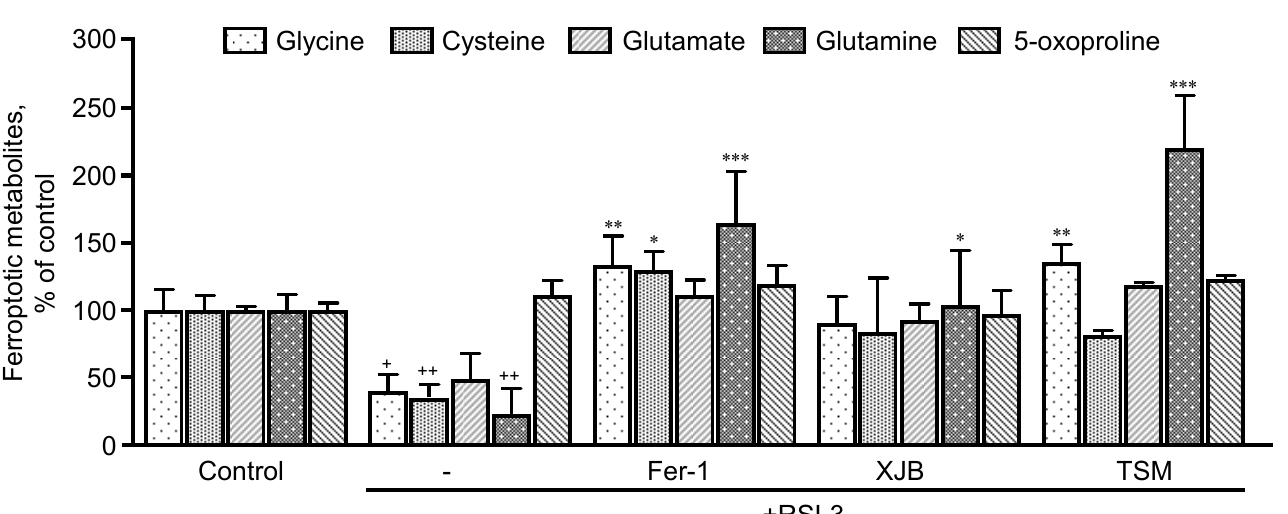
Figure 4. Precursor metabolites of GSH metabolism. Glycine, cysteine, glutamate, and glutamine represent GSH precursors, while 5-oxoproline is a marker of GSH degradation within the cell. Data are presented as a percentage of the control group. + p < 0.05, ++ p < 0.01 vs. control; * p < 0.05, ** p < 0.01 and *** p < 0.001 vs. RSL3. n = 4–6 per group.